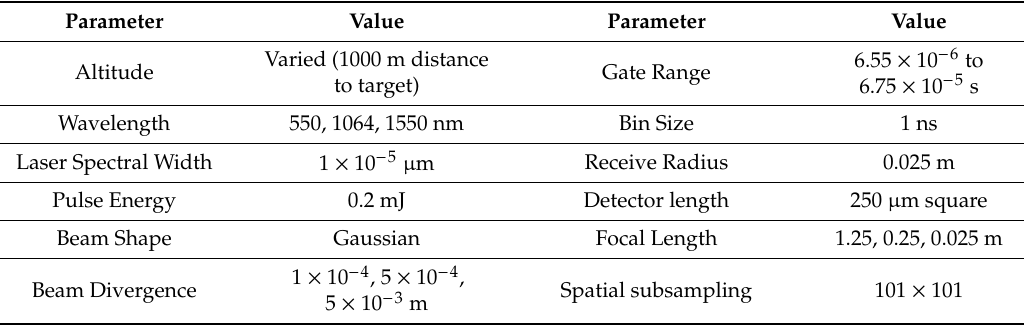
Table 4. DIRSIG lidar settings for BSDF sensitivity